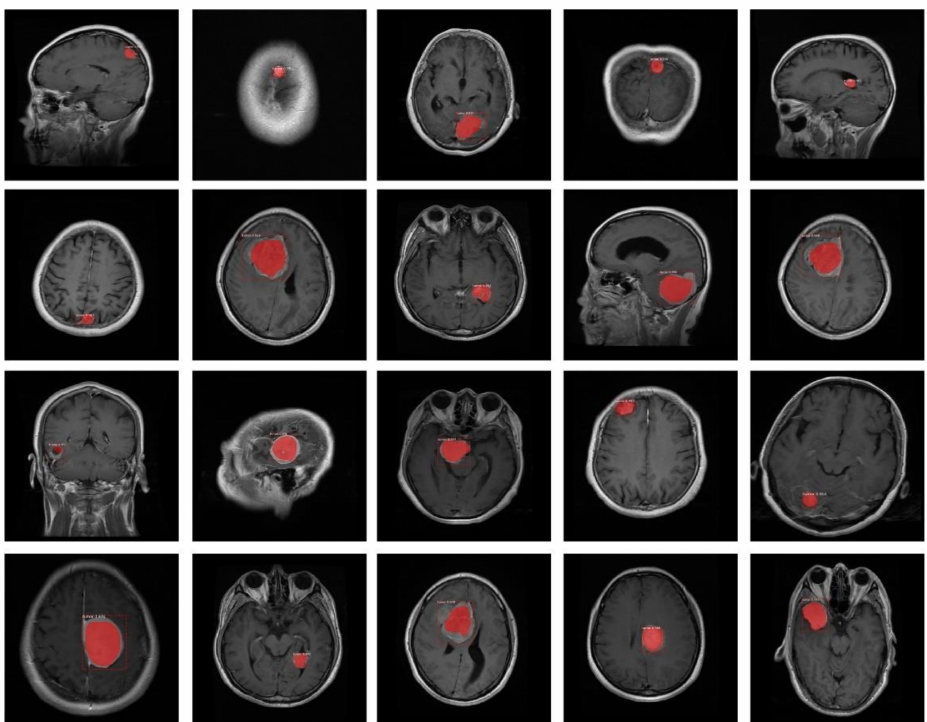
Figure 8. Example segmentation results of high-score-obtaining test images using the proposed method. The red contour shows the predicted tumor mask.